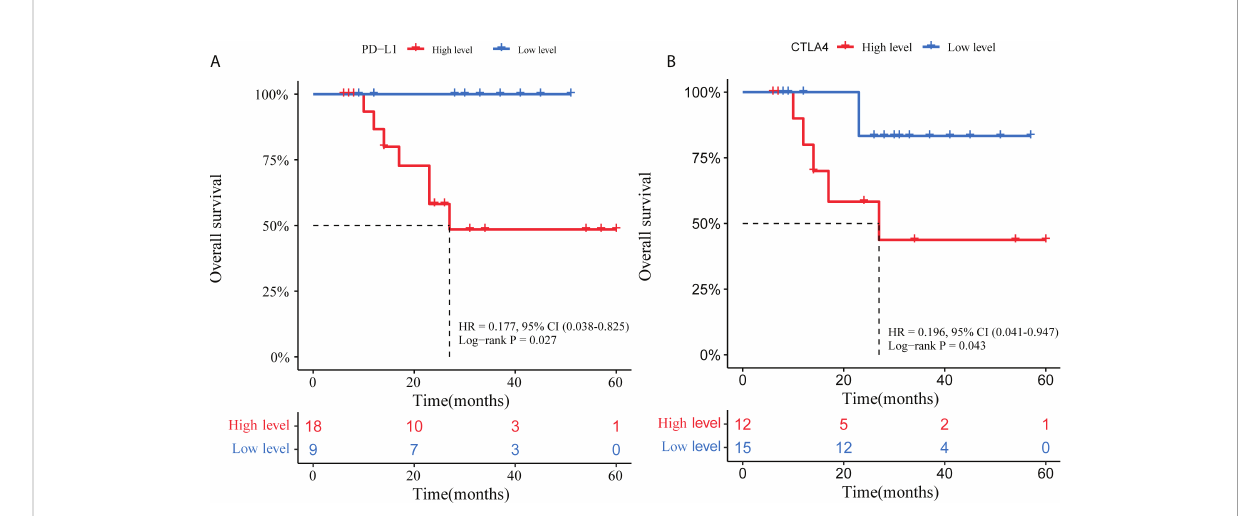
FIGURE 7 Overall survival Kaplan-Meier curves by PD-L1 (A) and CTLA4 (B)